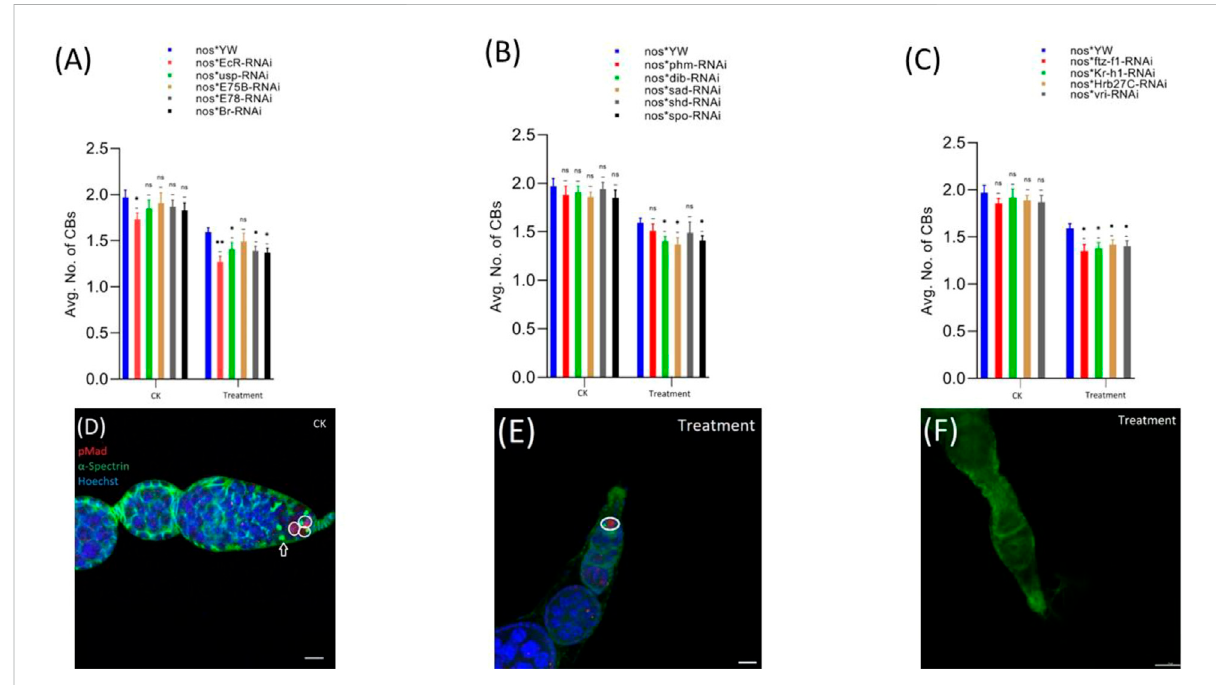
FIGURE 4 Effect of cyromazine on the CBs of adult ovaries. (A) RNAi of ecdysone-responsive primary genes and the effect of cyromazine on the CBs. (B) RNAiofHalloweengenesandtheeffectofcyromazineontheCBs. (C) RNAiofecdysone-responsivegenesandtheeffectofcyromazineontheCBs. CKmeansthatthe fl ieswerefedonanormaldiet,whiletreatmentmeansthe fl ieswerefedinsecticidecontainingdiet. (D) Theadultovariolefromthe CK group. White circle indicates GSCs, while white arrow represents CBs. (E) Only one GSCs and no CB can be seen against the cyromazine- treatedovariole. (F) Theovariolelackinganygermcellinthegermarium(scalebar,10 μ m (D,E) ,25 μ m (F) ).Forthe t -test:* p < 0.05;** p < 0.01;*** p < 0.001; ns indicates not signi fi cant ( p > 0.05).